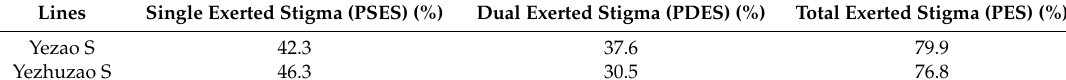
Table 4. Comparison of stigma exsertion rate between “Yezao S” and “Yezhuzao S.” . Lines